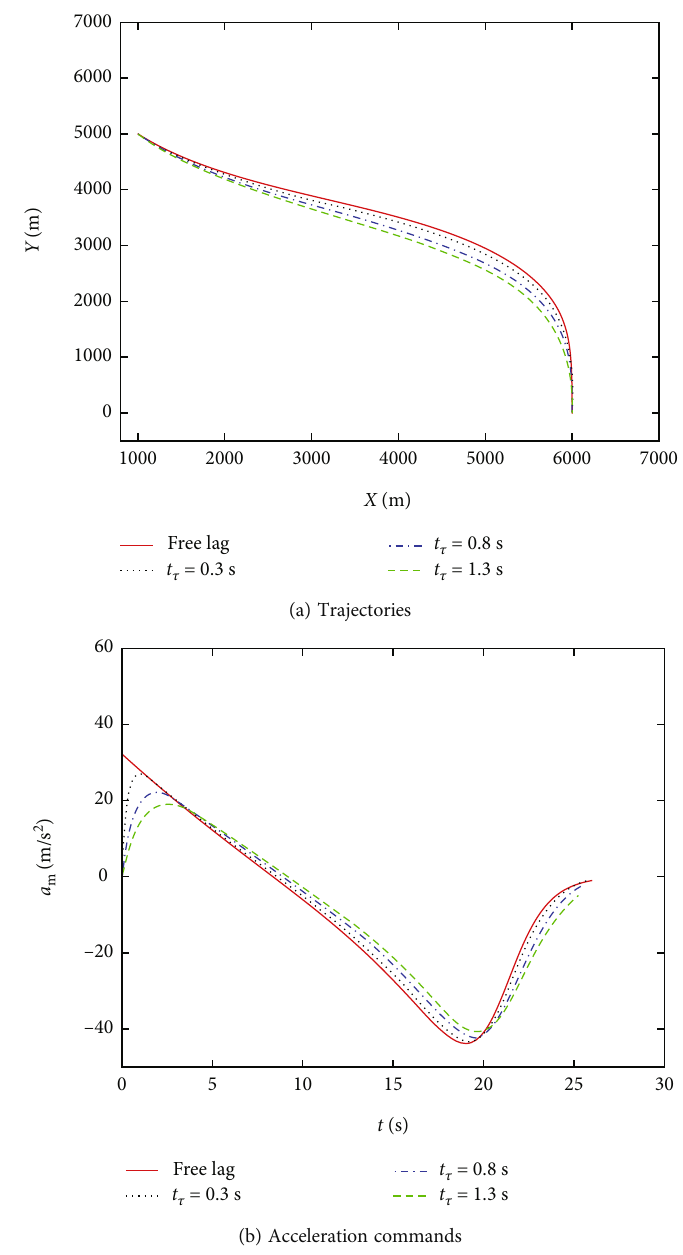
Figure 19: Trajectories and commands of the weighting function S ð 1 Þ